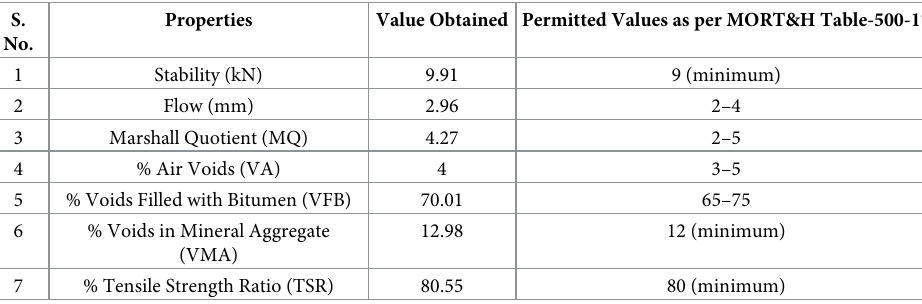
Table 7. Volumetric properties of bituminous mix at OBC of